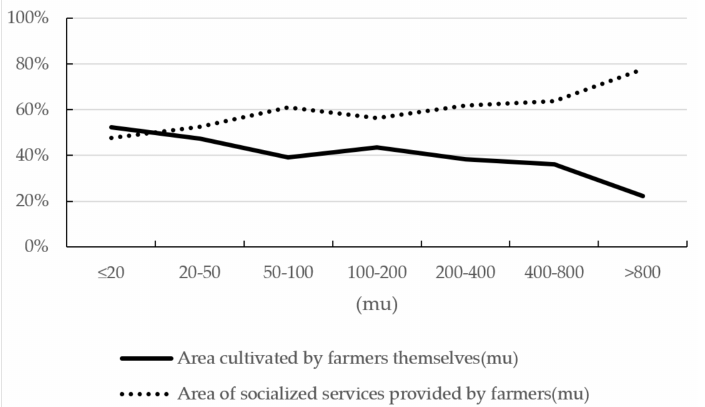
Figure 3. Proportion of farmers’ self-cultivation and socialized services area in the total operating